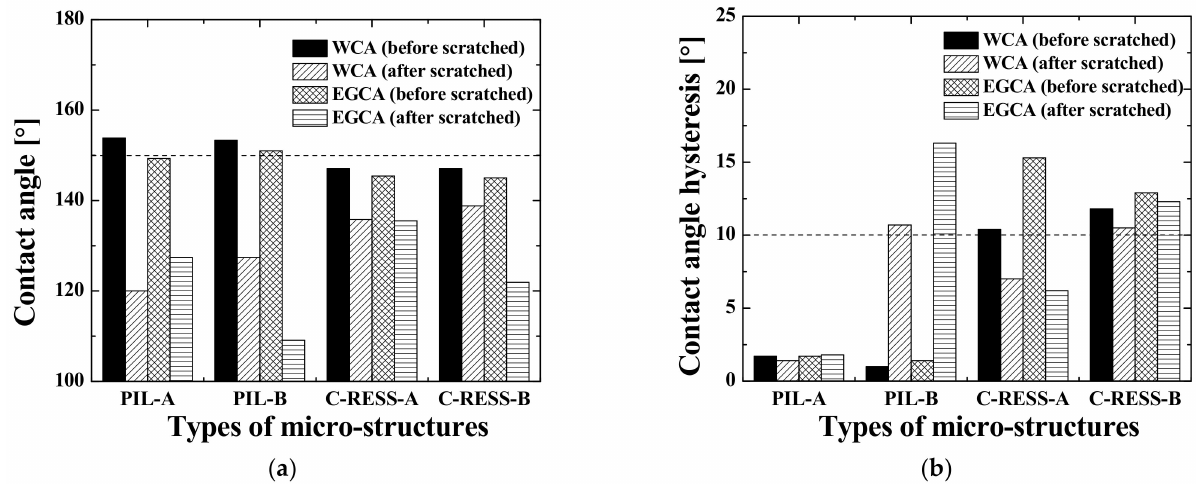
Figure 22. Comparison of the surface wetting properties of the PIL and C-RESS replicated micro-structures before and after scratch tests ( a ) water and ethylene glycol contact angle (WCA and EGCA) and ( b ) contact angle hysteresis